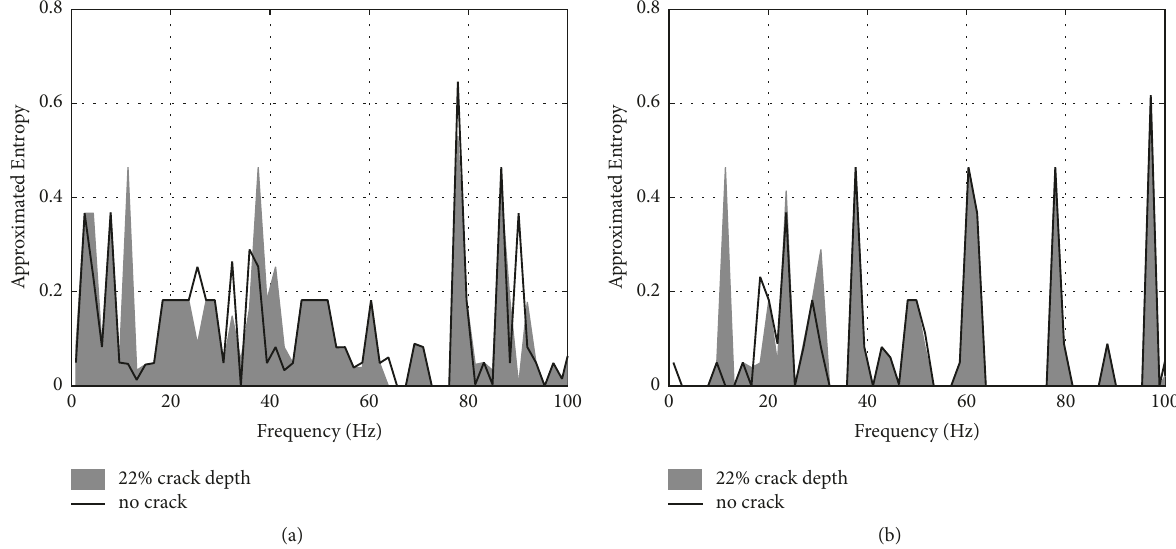
Figure 16: Approximated Entropy of the experimental FFTs of the rotating system. Comparison between the cases of healthy and cracked shaft: (a) response at node #8 ( 𝑁 = 7 , 𝑝 = 2 , and 𝑟 = 1 × 10 −8 ); (b) response at node #28 ( 𝑁 = 7 , 𝑝 = 2 , and 𝑟 = 5 × 10 −8